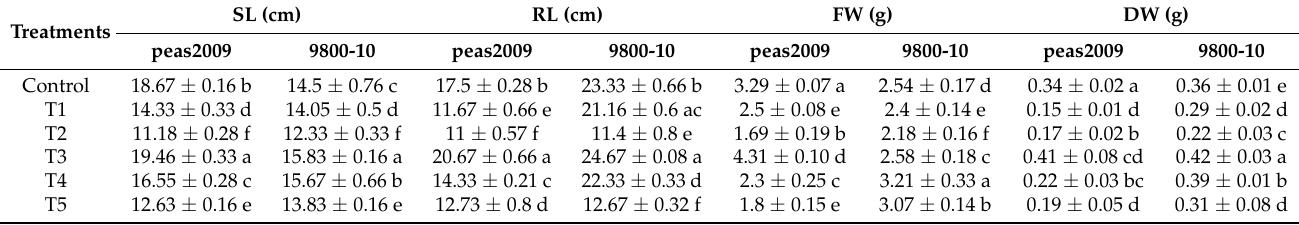
Table 2. Influence of Kocuria rhizophila inoculation on shoot length (SL), root length (RL), fresh weight (FW), and dry weight (DW) of pea varieties, i.e., peas2009 and 9800-10 grown under salinity stress. All values are means ± standard error of three replicates at the level of p ~0.05. Where T1 = 75 mM NaCl, T2 = 150 mM Nacl, T3 = inoculated with K. rhizophila, T4 = 75 mM of Nacl + K. rhizophila , and T5 = 150 mM Nacl + K. rhizophila . Averages with matching lower-case letters in the same column and upper-case letters in the same row are not significantly different according to the LSD grouping test ( p ≤ 0.05).